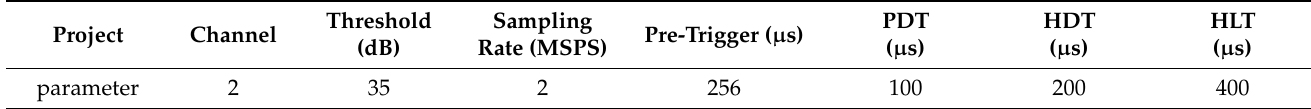
Figure 1. Mode detection experimental scheme ( a ) sensors layout diagram; ( b ) Distances in mm. Table 1. Parameter setting of the AE monitoring